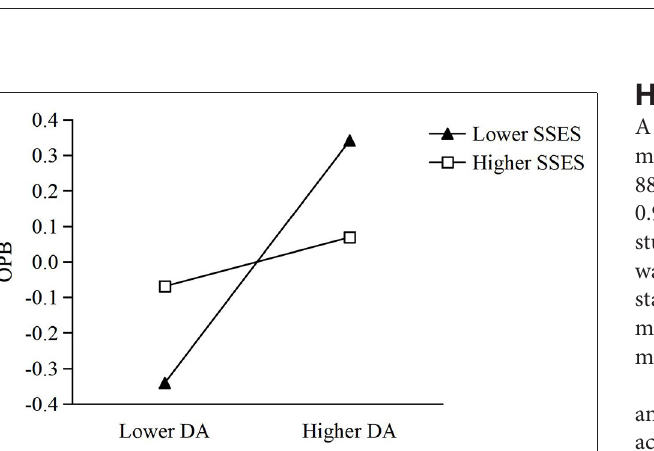
FIGURE 2 | The standardized path coefficients of hypothesized model. SSES, subjective socioeconomic status; DA, dispositional awe; STML, self-transcendent meaning in life; OPB, online prosocial behavior. Note: * p < 0.05, ** p < 0.01, *** p < 0.001.